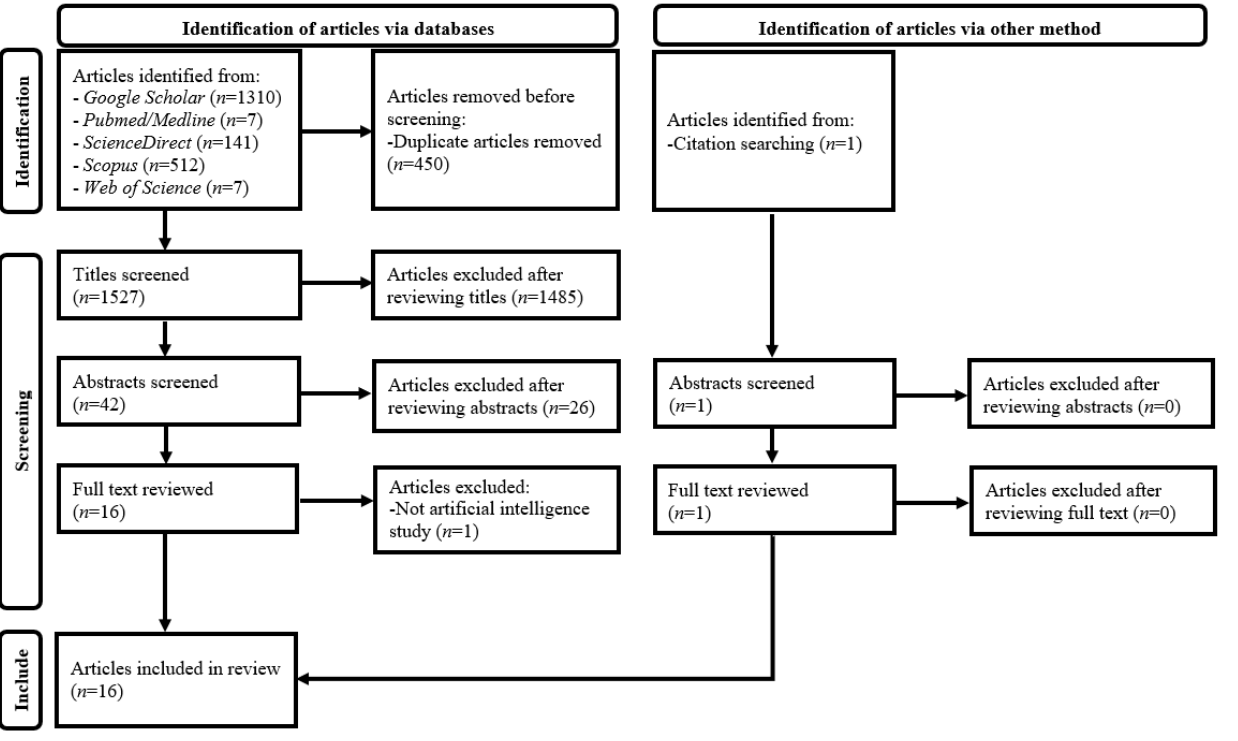
Figure 1. PRISMA flow diagram for systematic review of artificial intelligence for radiation dose optimization in pediatric radiology.